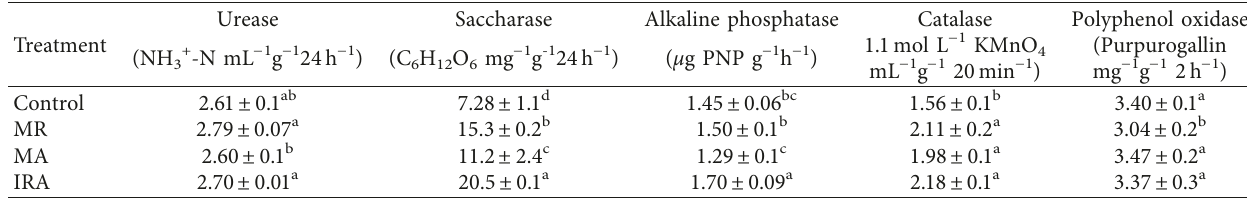
Table 4: Soil enzyme activities after plant harvest under the different treatments.